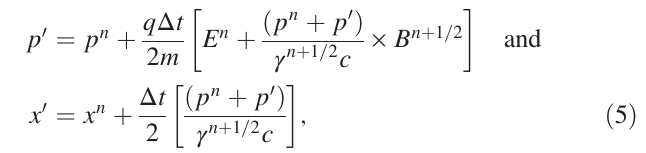
FIG. 2. The time centering for the MI algorithm is shown schematically for both fields and particles. The first pushes of fields and particles are shown via blue arrows to interim ( x 0 , p 0 ) or half step ( B ′ )